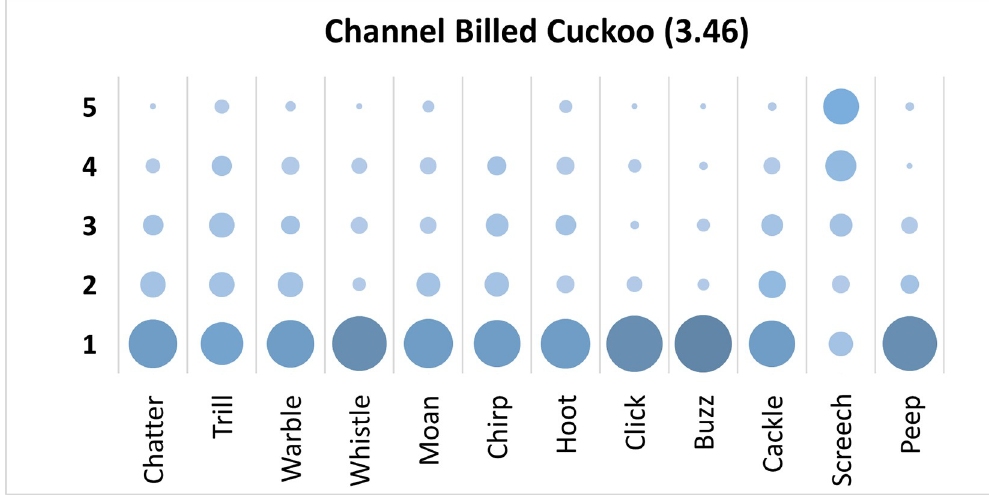
Fig 1. Count of participants’ sound descriptions scores for the Channel Billed Cuckoo with confidence ratings in brackets.